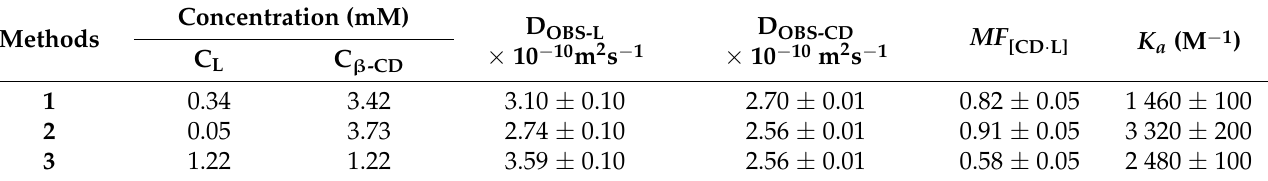
Table 5. The PGSE data for the binding of KP to β -CD 1